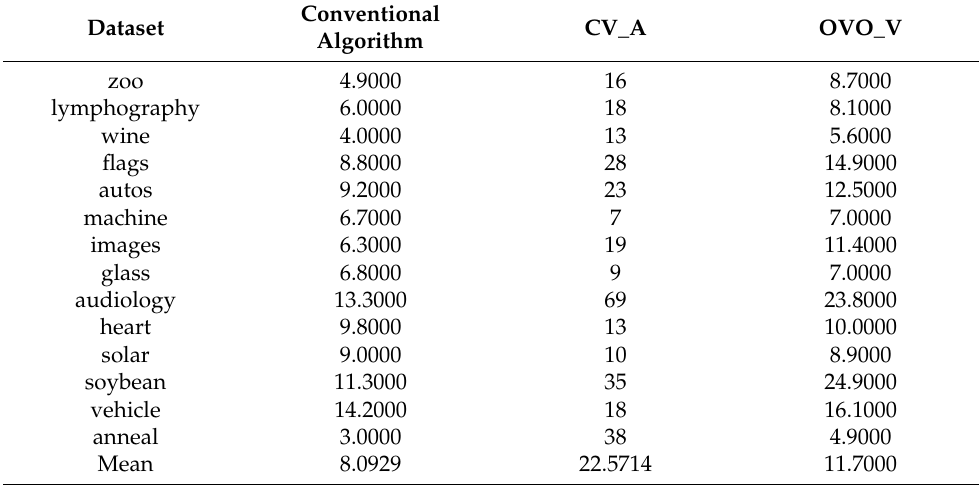
Table 7. Numbers of attributes obtained by the method based on all features and other